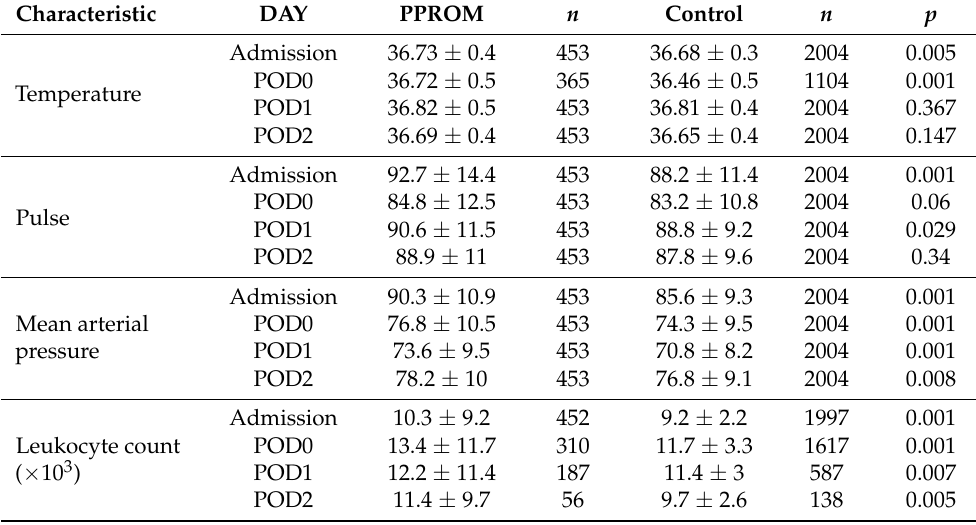
Table 2. Vital signs and white cell counts of study group versus control group. PPROM: preterm premature rupture of membranes; POD: post-operation